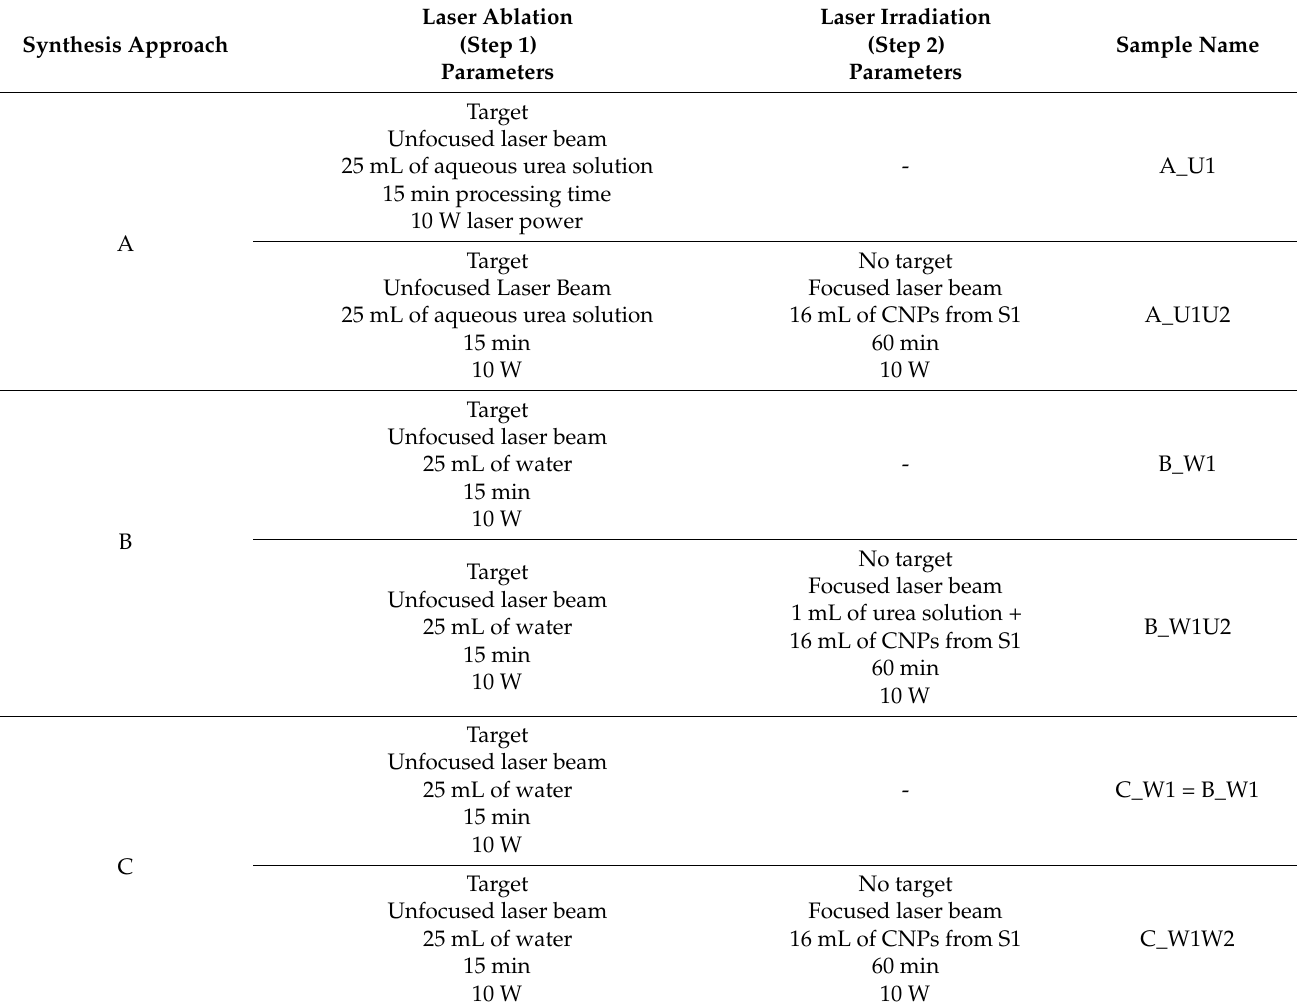
Table 1. Notation and synthesis parameters of carbon nanoparticle